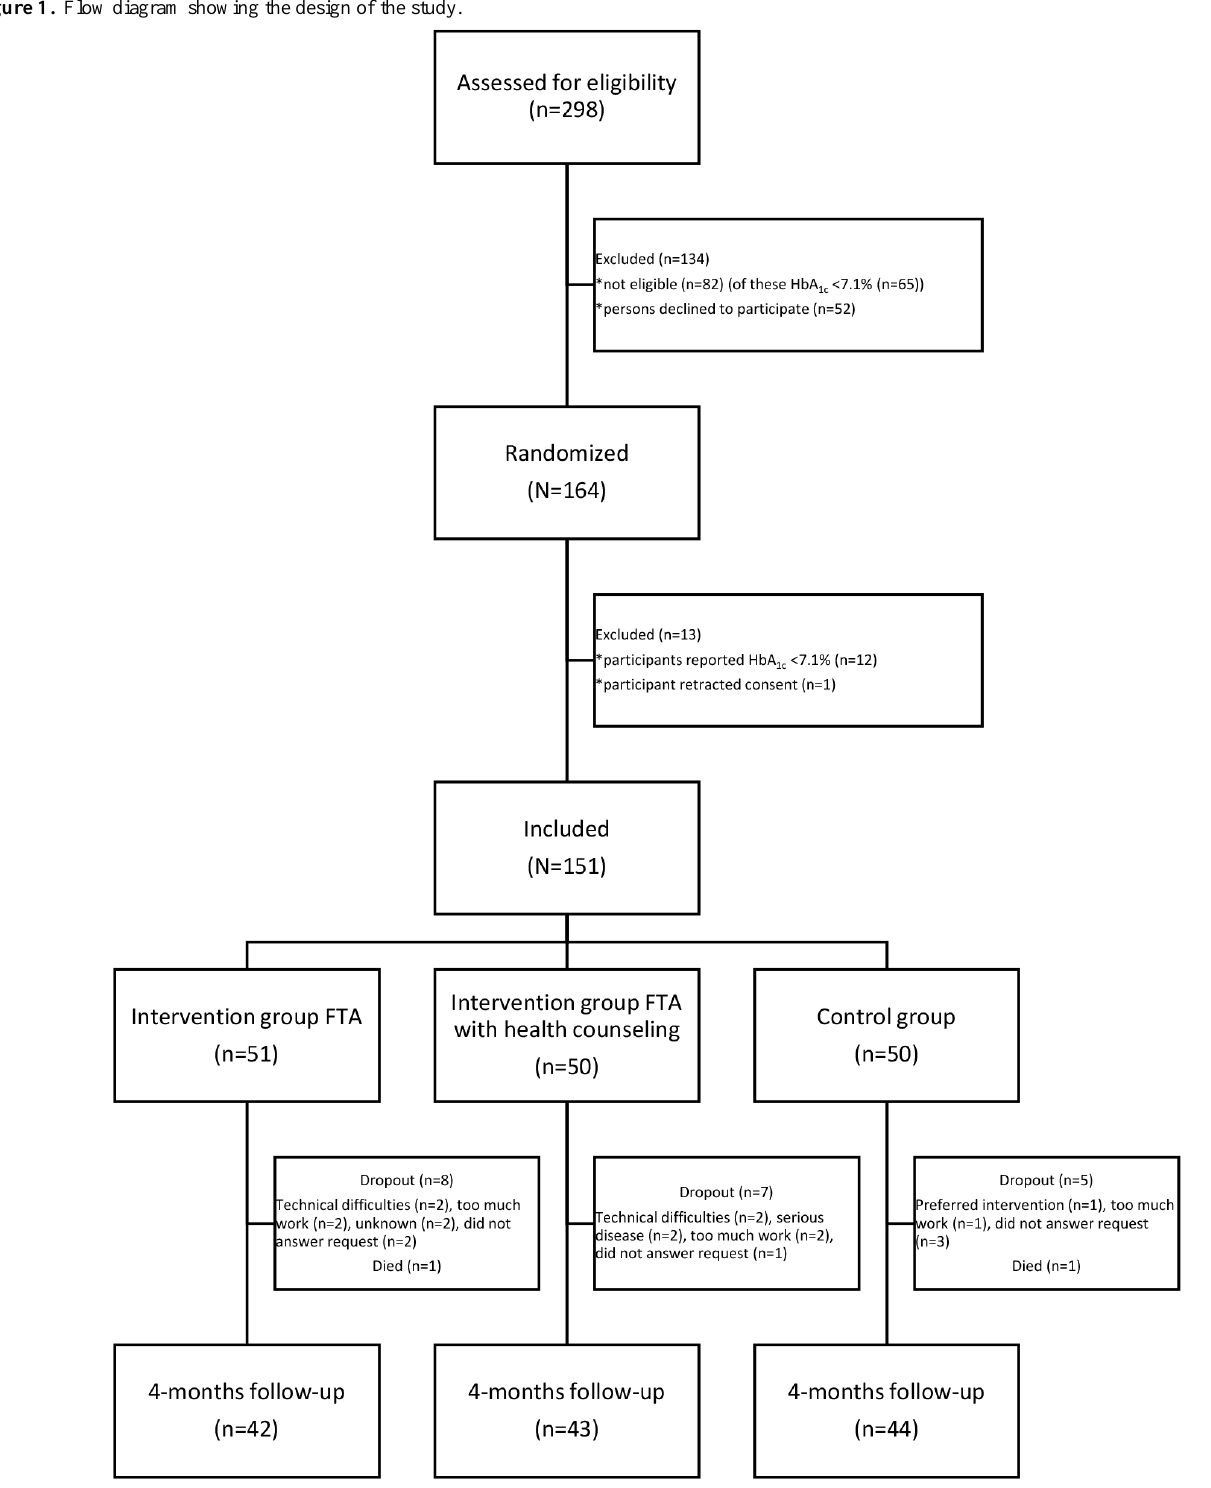
Figure 1. Flow diagram showing the design of the